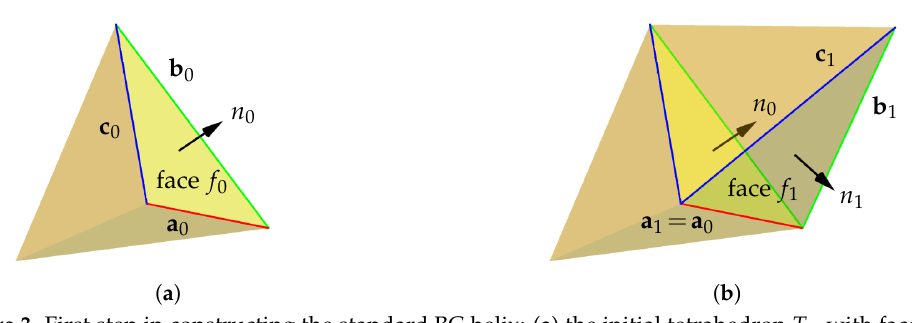
Figure 3. First step in constructing the standard BC helix: ( a ) the initial tetrahedron T 0 , with face f 0 , edges { a 0 , b 0 , c 0 }, and normal n 0 ; ( b ) T 0 with T 1 and the transformed face, edges, and face